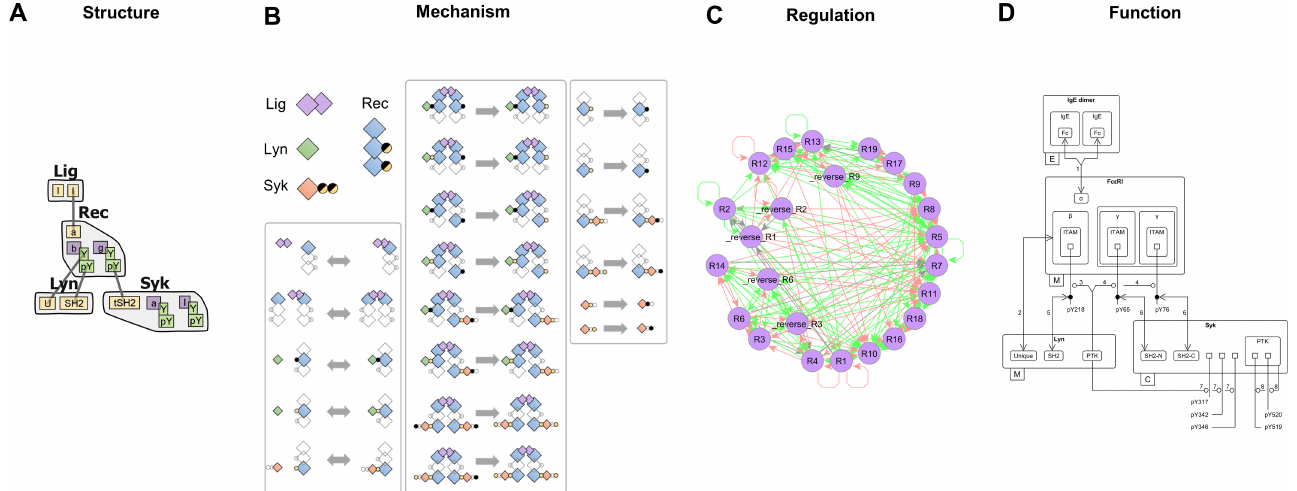
Fig 1. Visualization of an immunoreceptor signaling model [9]. (A) Contact map showingthe types of moleculesin the model (Lig, Rec, Lyn, Syk), their components,and the internalstates ( Y , pY ) and bondsavailableto those components. (B) The 24 rules in the model visualizedas reactant- to-producttransformations, showingwhat structures need to be matched for each rule to be triggered.(C) Rule influencediagramshowing interactions betweenpairs of rules, computedby explicitlycomparing each pair of rules from panel B. (D) ExtendedContact Map drawn by manually interpretingthe model accordingto a definedset of conventions [23]. Each diagram in panelsB-D raises specific complexity and usabilityissues (see main text).